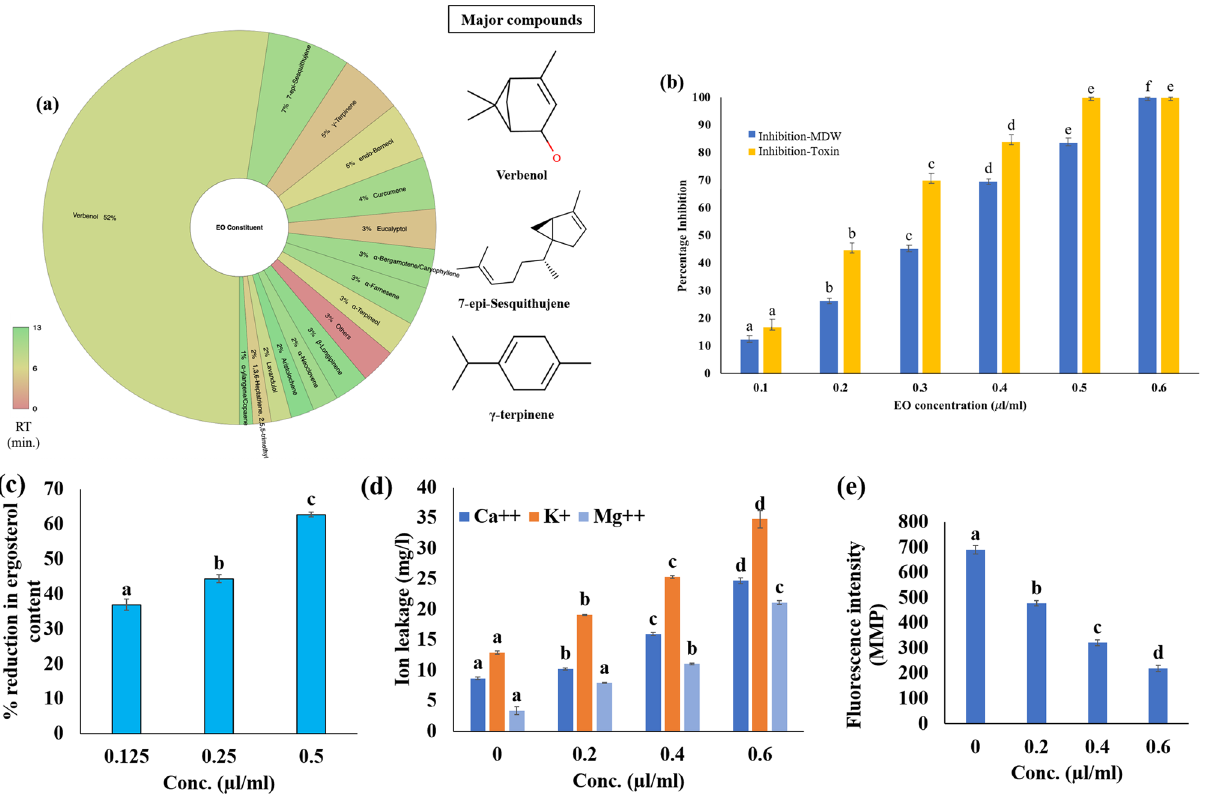
Figure 2. In-vitro analysis: ( a ) chemical profile of ZOEO; ( b ) anti-fungal and anti-aflatoxigenic activity of ZOEO; ( c ) % inhibition of ergosterol content; ( d ) vital cellular ion leakage; ( e ) mitochondrial membrane